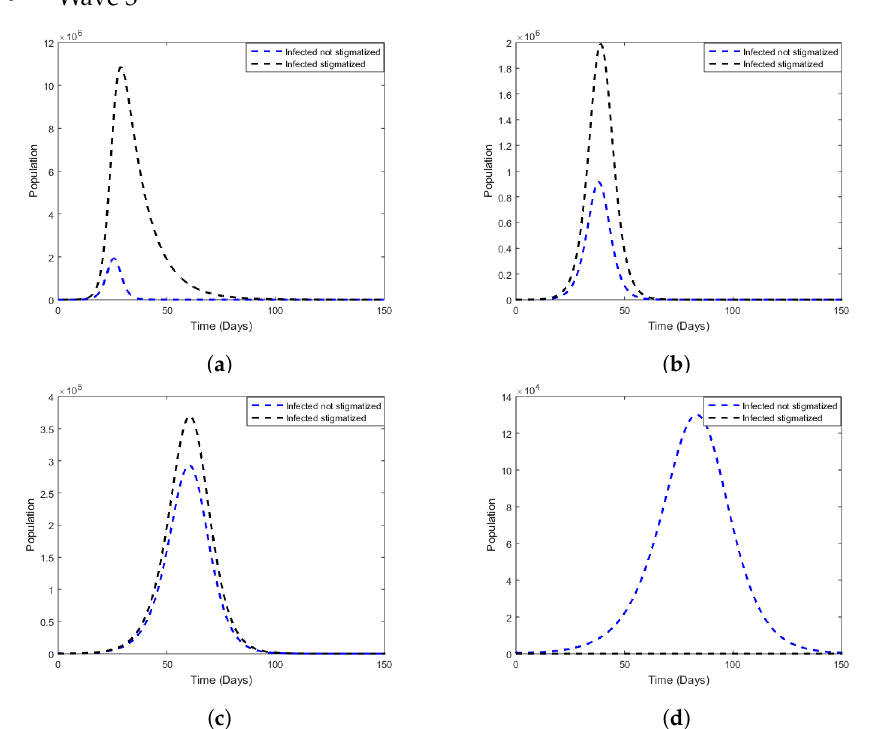
Figure 7. Comparison between non-stigmatised and stigmatised populations, varying γ for fixed values of p for the cases where there is stigma. ( a ) High stigma, γ = 0 and p = 0.49. ( b ) Moderate stigma, γ = 0.4 and p = 0.49. ( c ) Low stigma, γ = 0.8 and p = 0.49. ( d ) Stigma-free, γ = 0 and p =